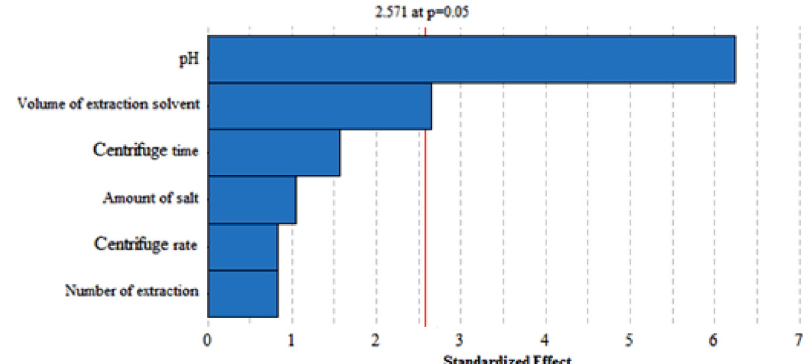
Figure 2 . Pareto chart of the main effects obtained from the Plackett–Burman design.